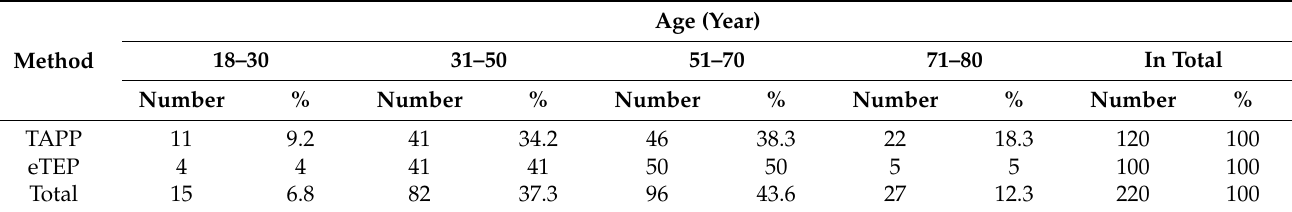
Table 1. Distribution of patients by age and